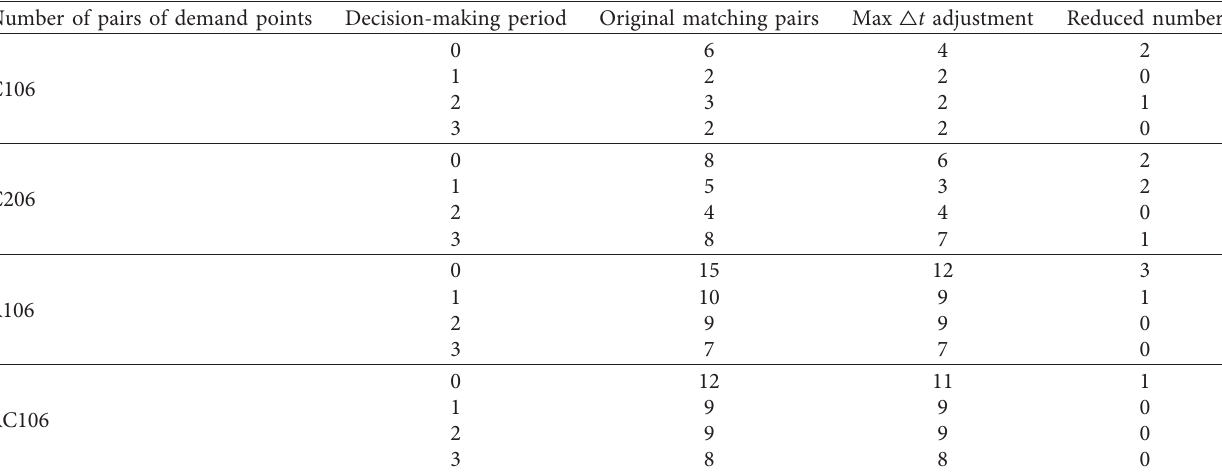
Table 2: Comparison of the number of pairs of demand